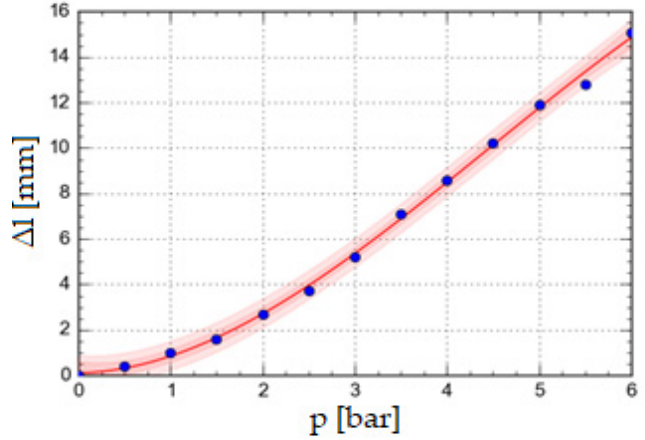
Figure 5. Polynomial regression curve: inflation. The polynomial regression that best fits the measured values for inflation is one of a third degree, as seen in Equation (1):